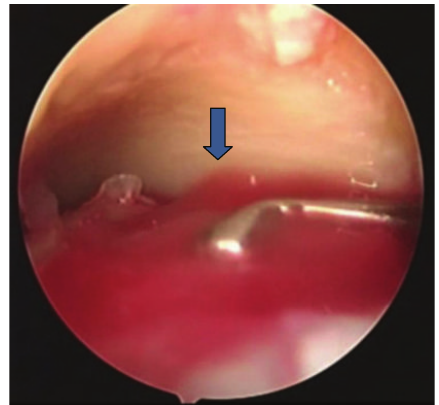
Figure 2: In the 2nd step, after about 30 days, the chondrocytes (arrow) were implanted on the lesion, fixing the matrix with fibrin glue.